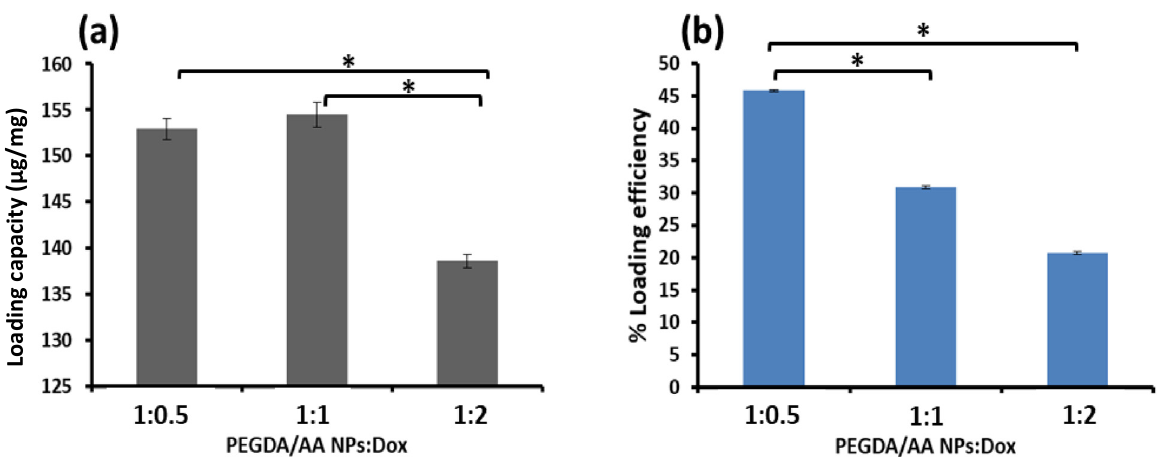
Figure 4. The ( a ) LC and ( b ) %LE of the Dox-loaded PEGDA/AA NPs. (* Significant difference at 95% CI) The drug experiments and Dox quantification were performed in triplicate. Each column represents the mean LC and %LE with standard deviation labelled.